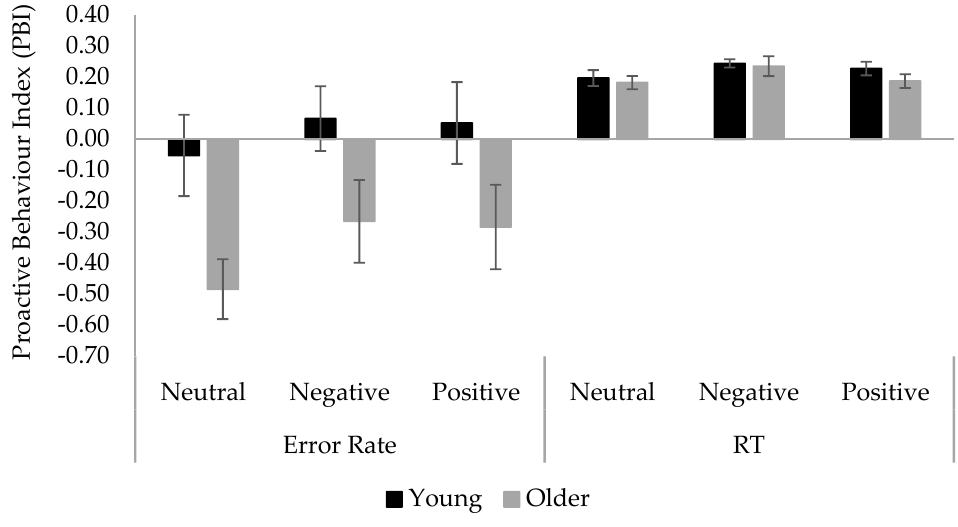
Figure 6. Mean Proactive Behavior Index (PBI) in error rate and RT across age and mood conditions in Experiment 2. Error bars denote standard error.